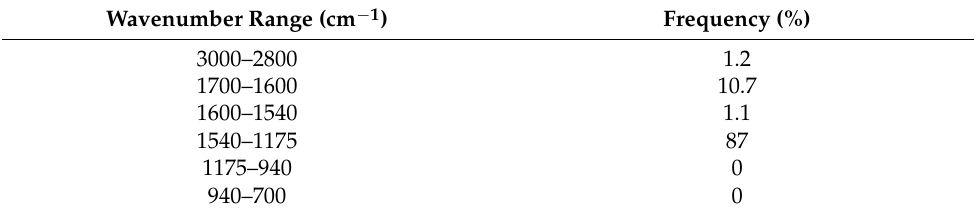
Table 1. Distribution of important wavelengths across preselected